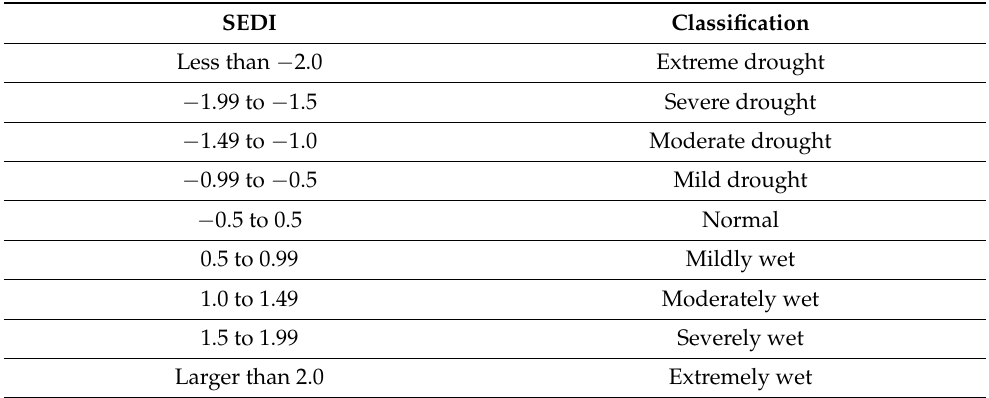
Larger than 2.0 Extremely